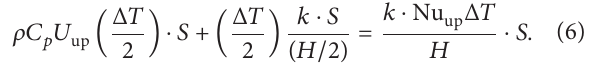
Figure 1: Temperature profile of a fluid layer with classical Rayleigh- Benard